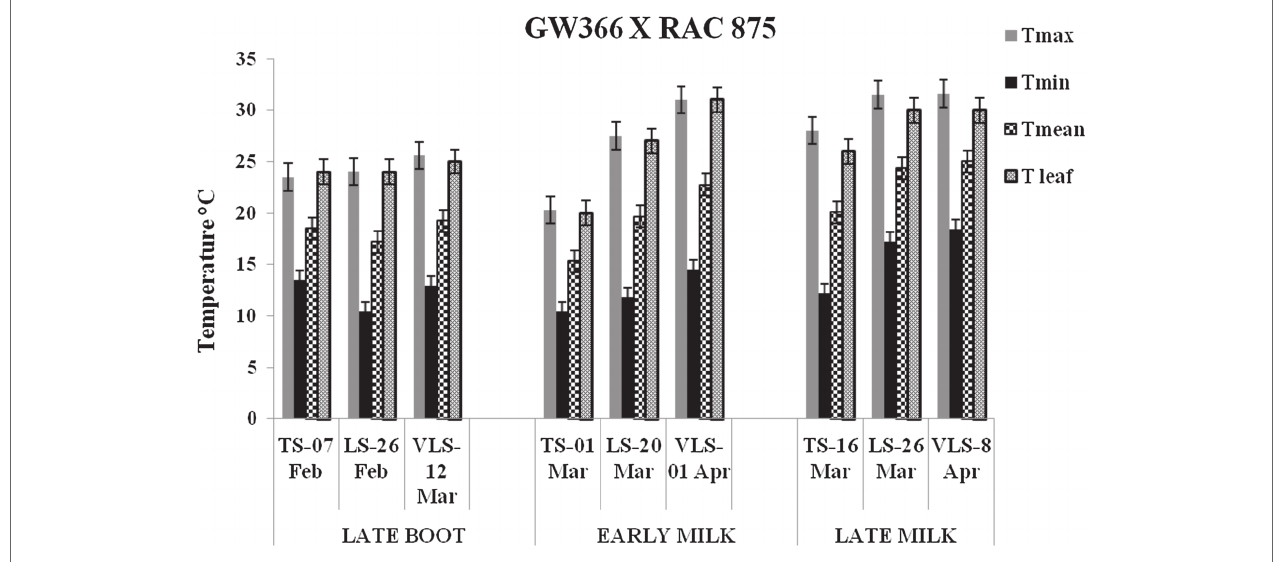
FIGURE 5 | Maximum temperature (Tmax), minimum temperature (Tmin), mean temperature (Tmean), and leaf temperature (Tleaf) in degree Celsius on the date of measuring stomatal conductance at late boot, early milk, and late milk stage under timely sown (TS), late sown (LS), and very late sown (VLS) condition for cross 4—GW 366 X RAC